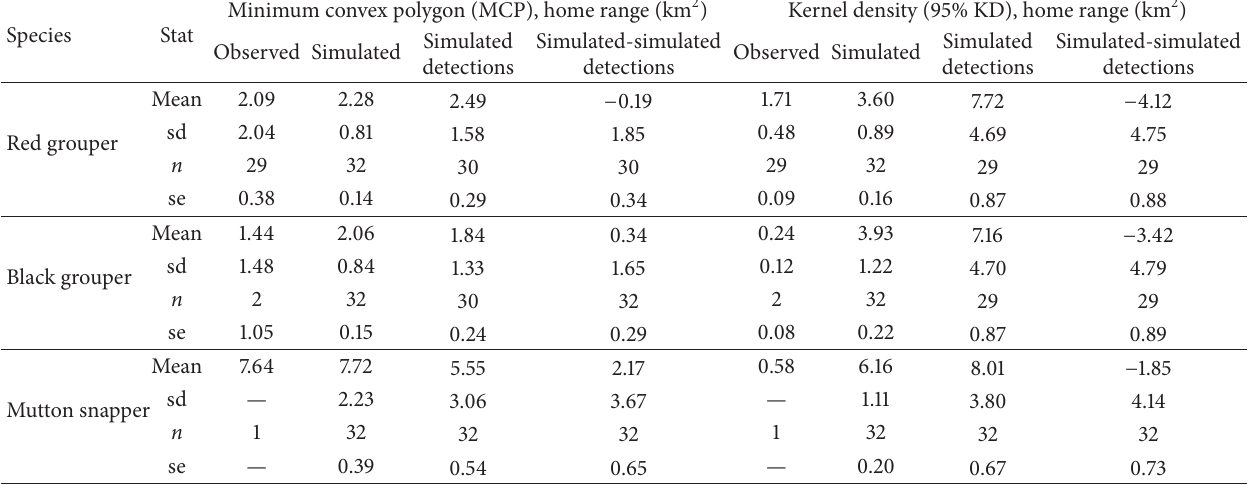
Table 2: Estimated home range areas (km 2 ) for empirically observed red grouper, black grouper, and mutton snapper compared to home range areas from simulated detection patterns and actual paths for simulated fish, with difference between simulated and simulated detection home range